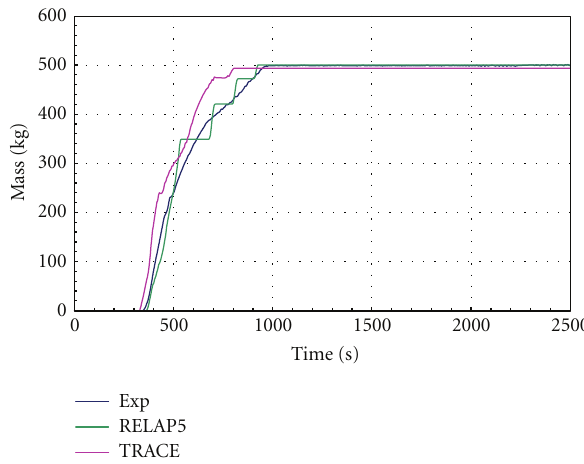
Figure 14: Intermediate leg 1DP (SG side).